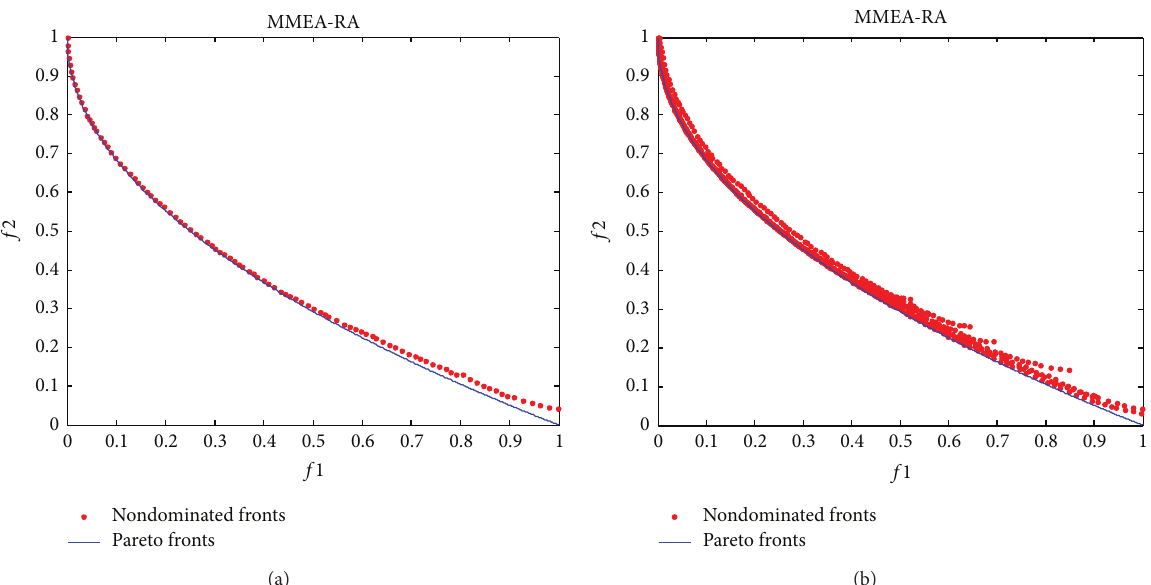
Figure 8: The final nondominated solutions and fronts found by MMEA-RA. (a) The result with the lowest 𝛾 -metric and (b) all the 10 fronts in 10 runs.